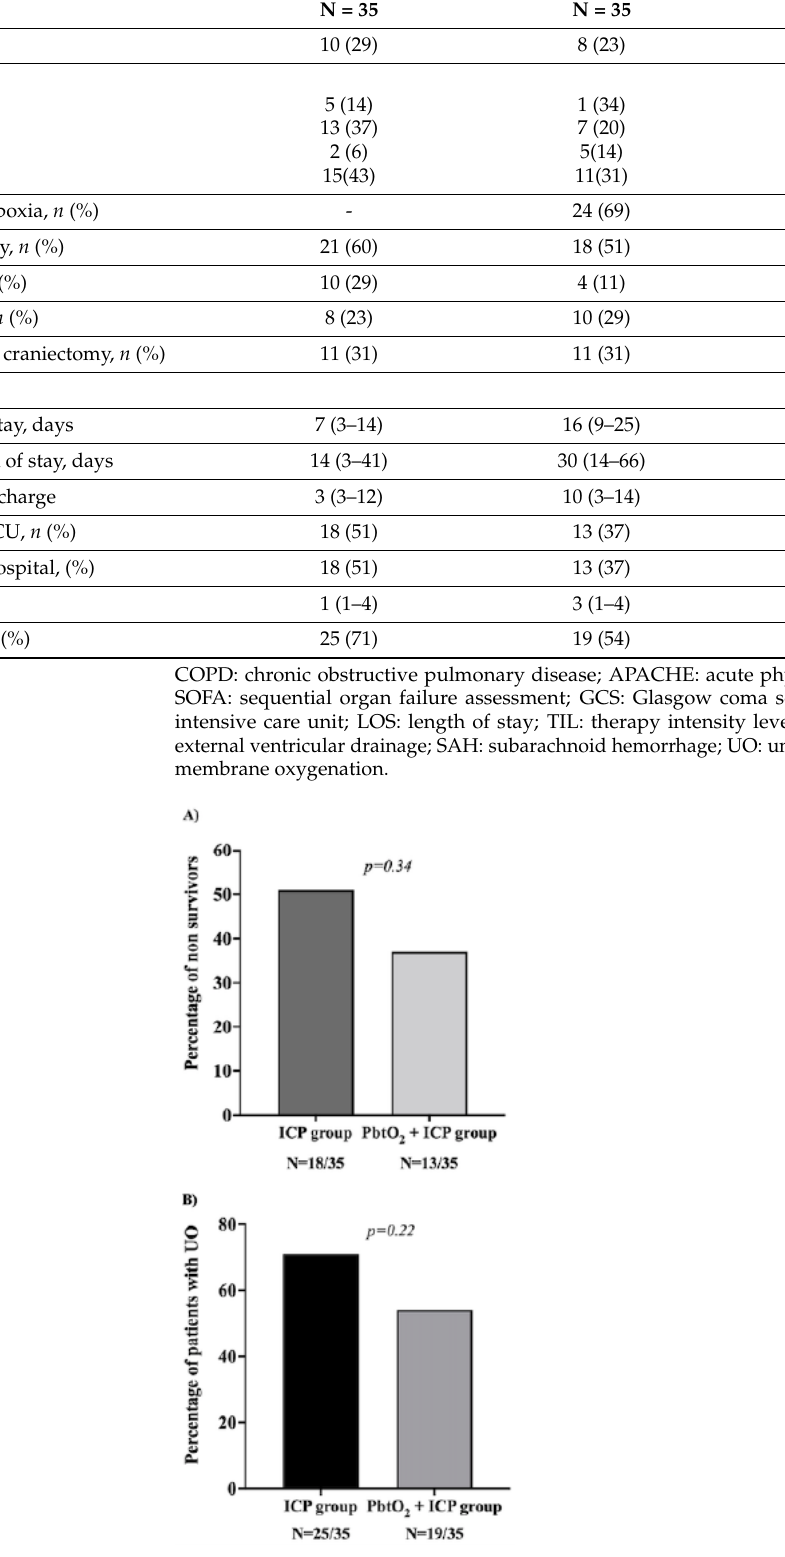
Figure 2. Outcomes according to type of monitoring strategy. Panel ( A ) hospital mortality; Panel ( B ) Unfavorable neurological outcome (UO) at 3 months (GOS 1–3). GOS: Glasgow outcome scale.